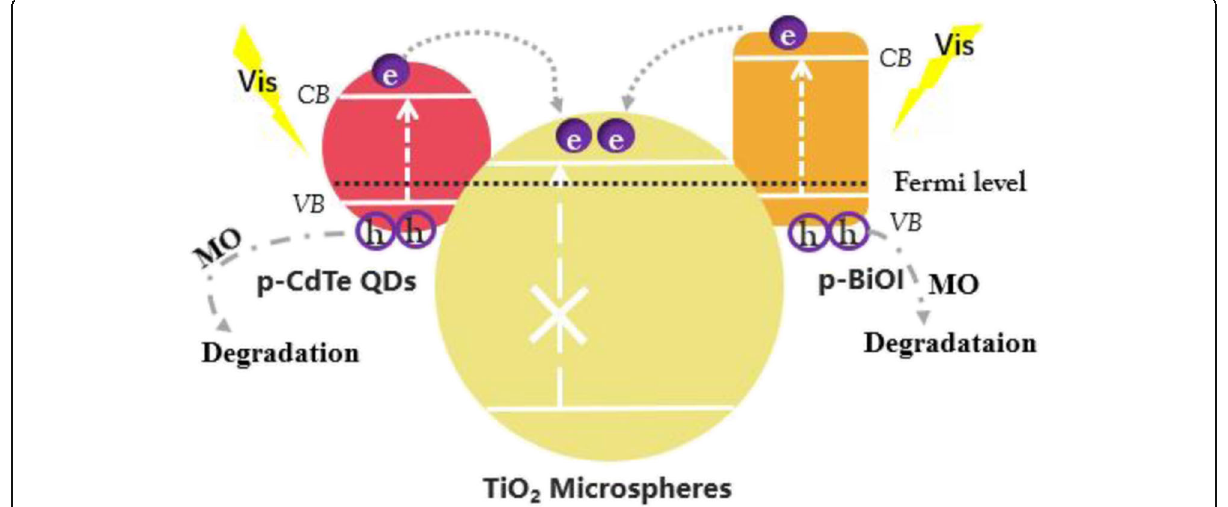
Scheme 2 Illustration of photo-induced charge transfer in ternary TiO 2 /CdTe/BiOI photocatalytic